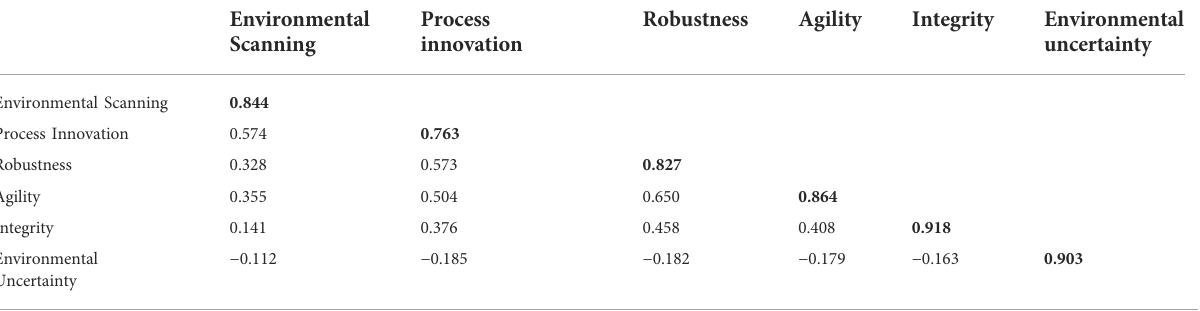
The values in boldface represent square roots of AVE.